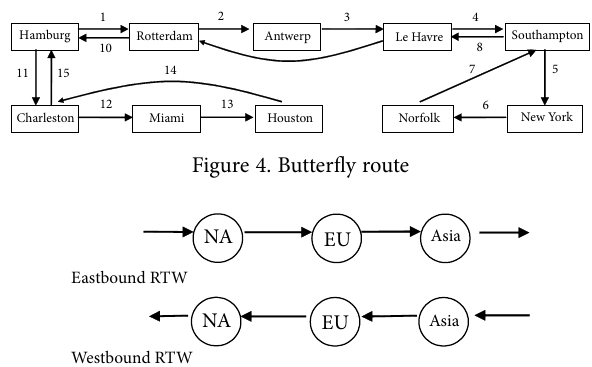
Figure 4. Butterfly route